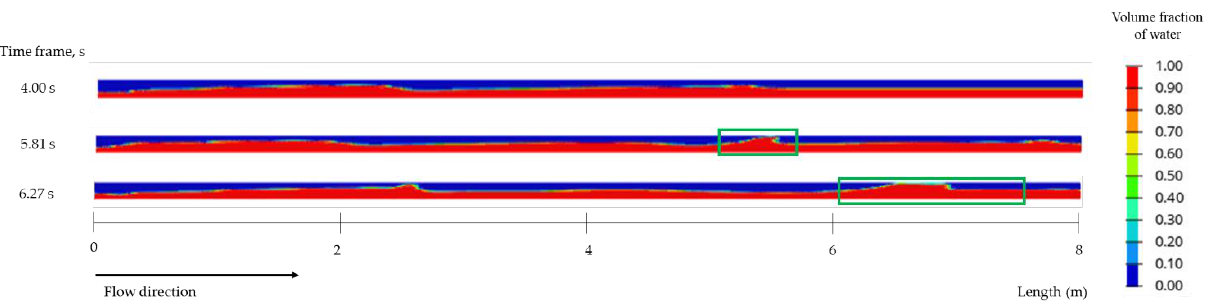
Figure 8. Flow morphology of model 1 which was extended up to simulation time of 9.8 s.